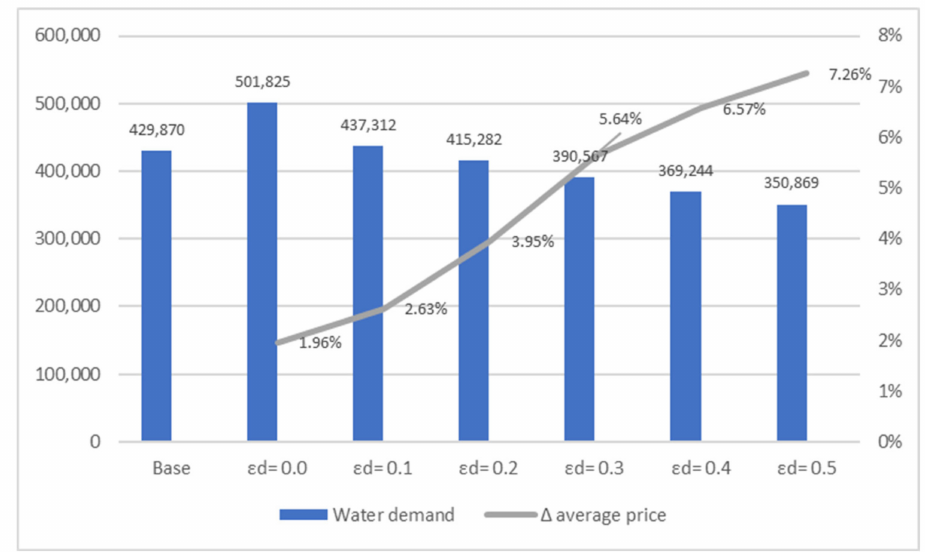
Figure 1. Sensitivity analysis. Water demand and annual average water price increase due to elasticity changes ( ε p